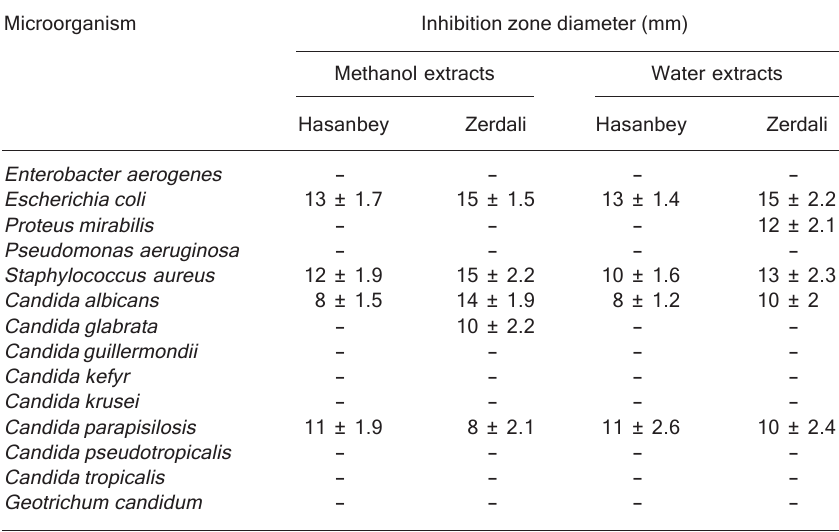
Table 2. Antimicrobial activity of methanol and water extracts of bitter (Zerdali) and sweet (Hasanbey) apricot (Prunus armeniaca L.) kernels against some clinical isolates.